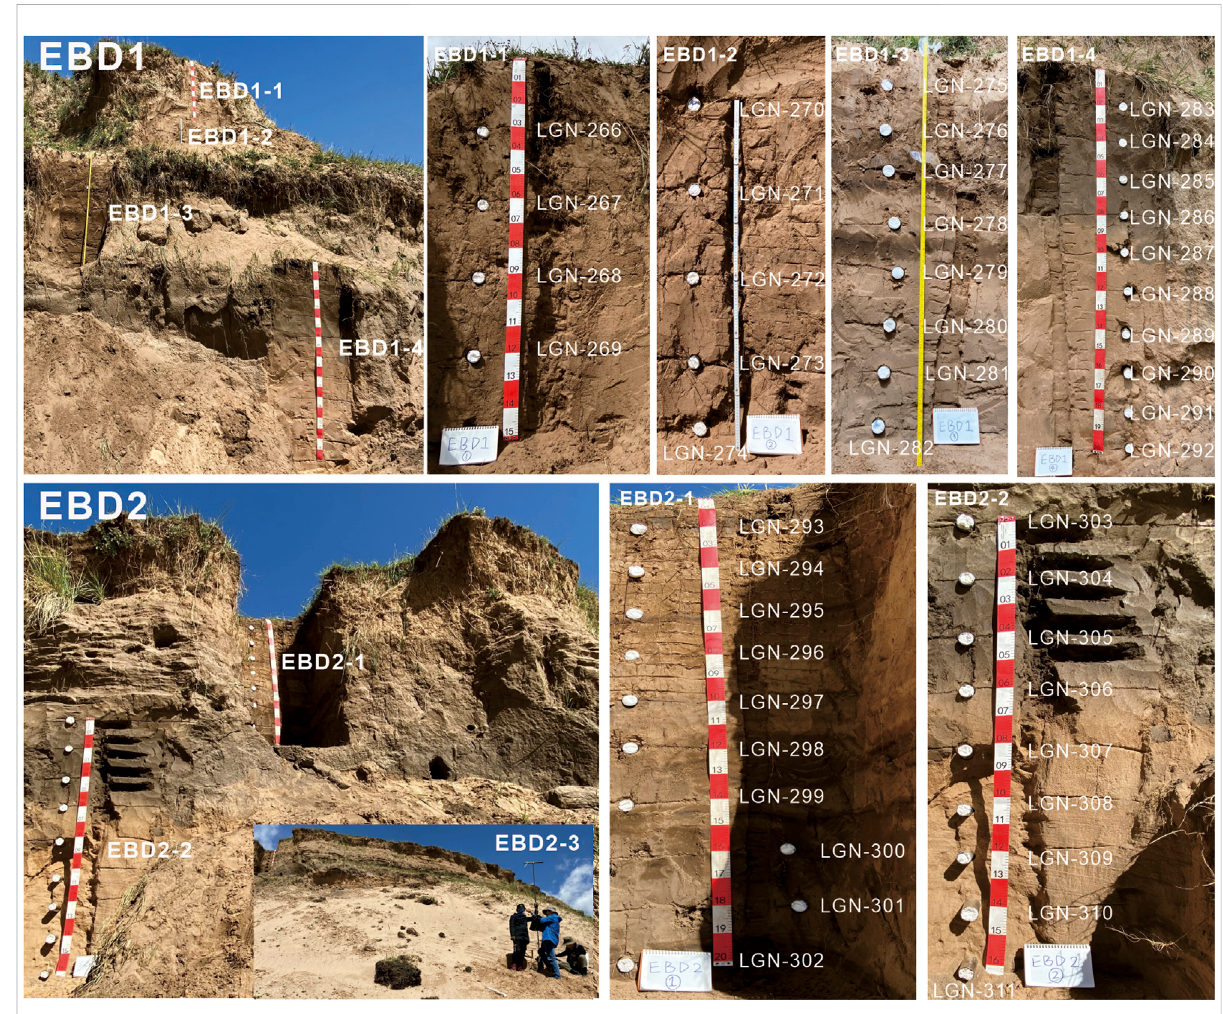
FIGURE 2 Overview and sedimentary variation photographs of two stacked aeolian sand palaeosol